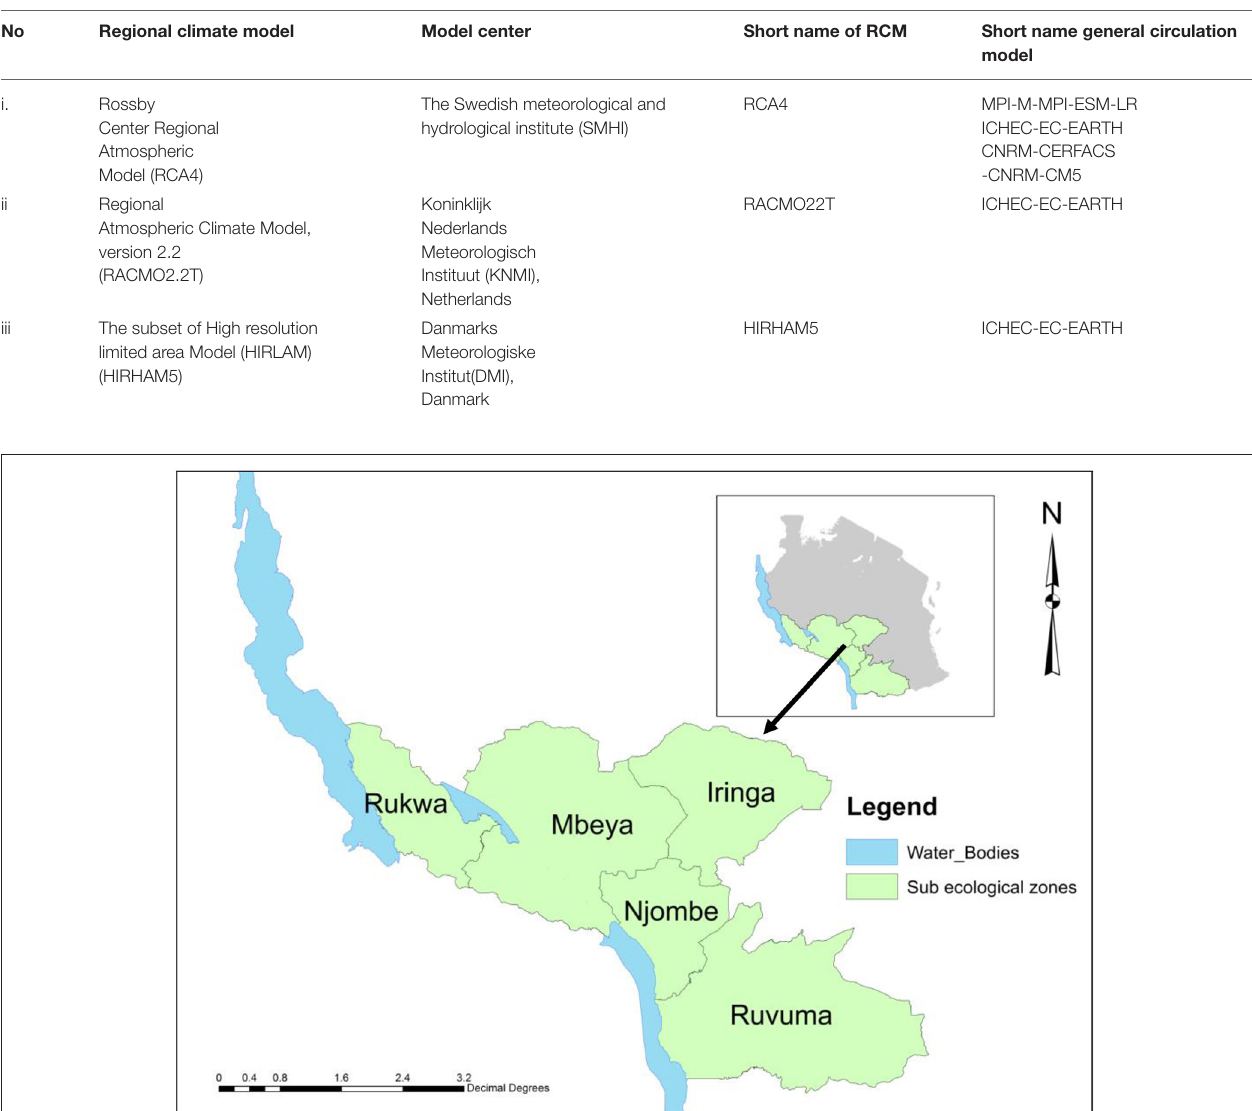
TABLE 1 | CORDEX RCMs and the driving GCMs.